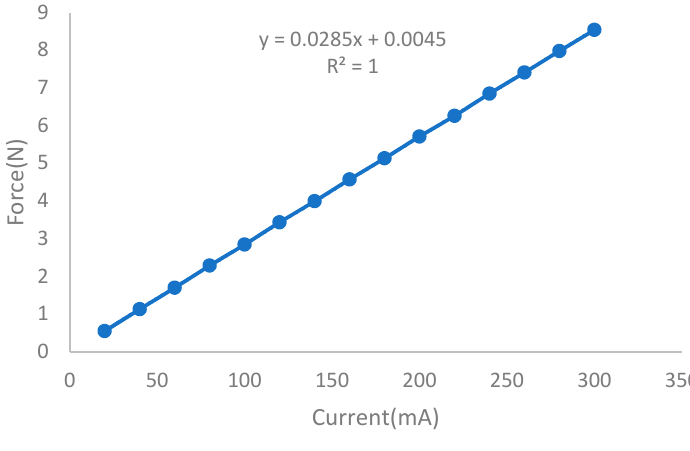
Figure 9. Force vs. current.